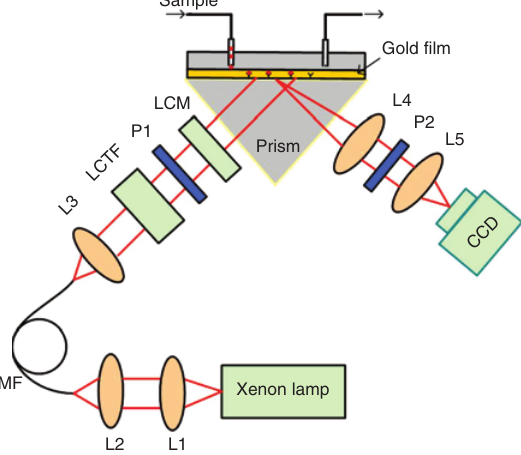
Figure 6: Phase-modulated SPR system. L1, L2, L3, L4, and L5, lenses; MF, multimode fiber; LCM, liquid crystal modulator. Reprinted with permission from Ref.